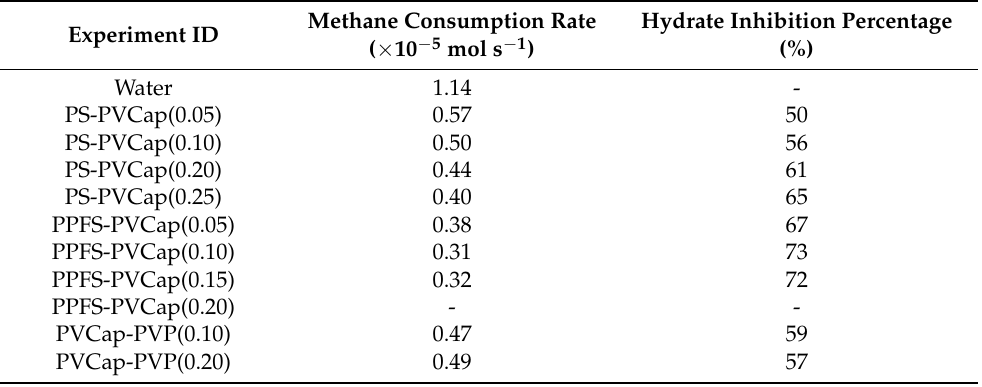
Table 6. Methane consumption rates and inhibition percentages for various block copolymer macro-